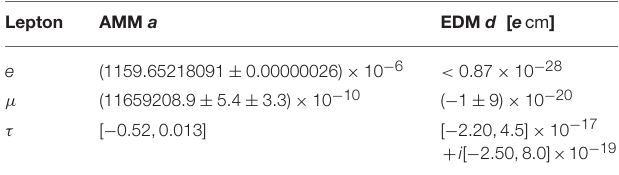
TABLE 5 | Experimental values for AMMs and EDMs